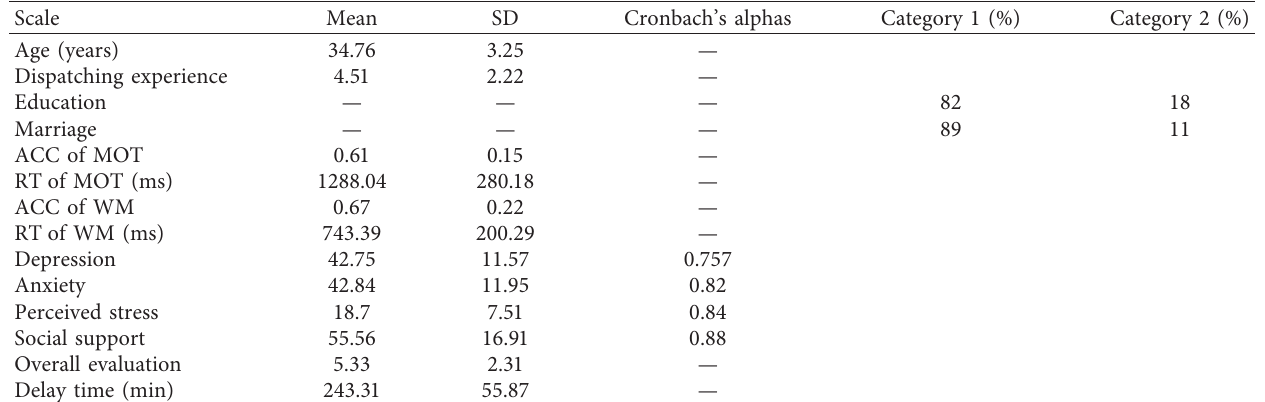
Table 2: Descriptive statistics of all variables ( n �